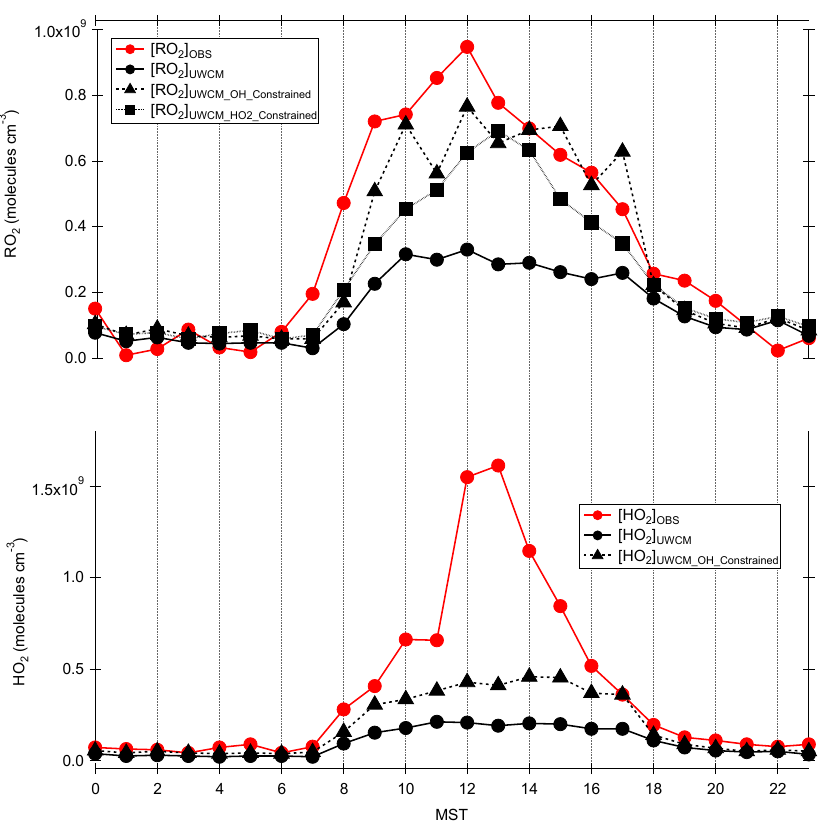
Figure 7 The daytime variations of observed OH reactivity and UWCM calculated OH reactivity from the various model scenarios, described in the text. Fig. 6. The averaged diurnal cycles of [HO 2 ] MEA , [HO 2 ] UWCM , and [HO 2 ] UWCM OH Constrained in the bottom panel and [RO 2 ] MEA , [RO 2 ] UWCM , and [RO 2 ] UWCM OH Constrained during the BEACHON-ROCS field campaign.